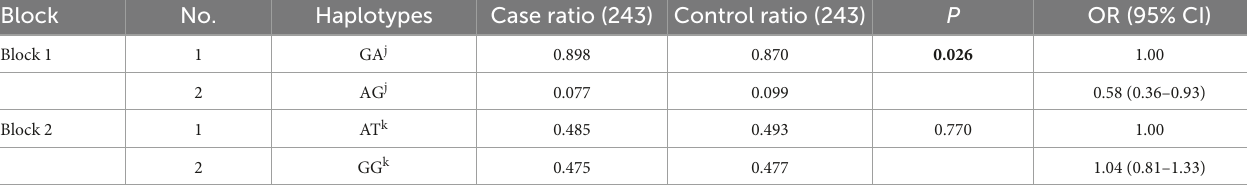
TABLE 7 Distribution of KCND2 haplotypes in cases and controls adjusted by age and sex (frequency more than 5). Block